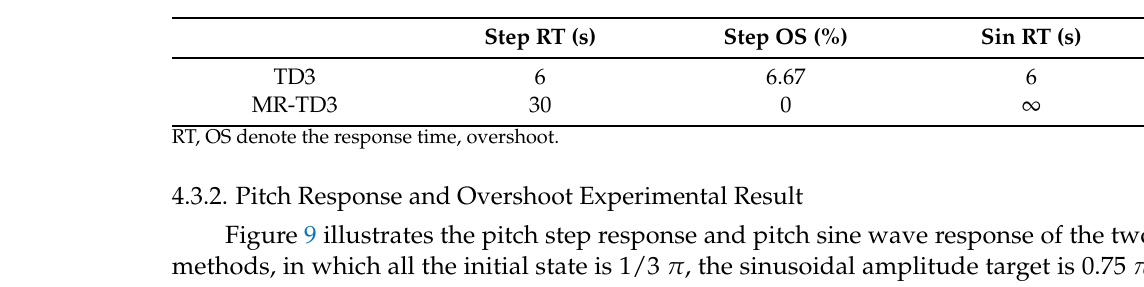
Figure 8. The depth channel response error of the TD3 and MR-TD3 agent. The error is the deviation between the reference target value and the actual agent response value. The step depth response is ( a ) and the sine depth response is ( b ). Table 3. Comparison of response time and overshoot in depth